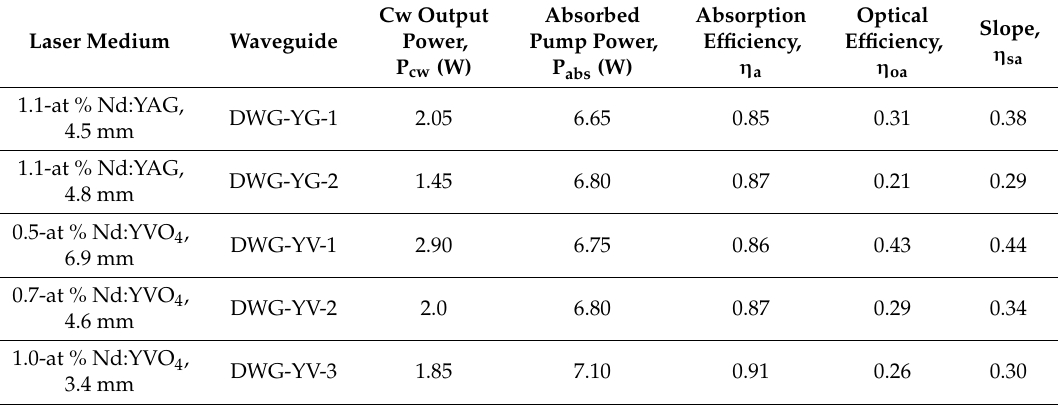
Table 1. Characteristics of cw laser emission at 1.06 µ m yielded by the circular, buried depressed-cladding waveguides realized in Nd:YAG (OCM with T = 0.05) and in Nd:YVO 4 (OCM with T = 0.10).